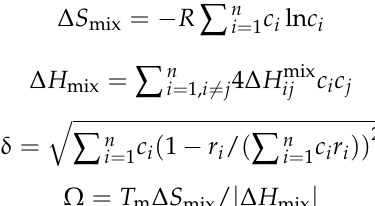
Table 1. Calculated parameters of the quasi-HEA microspheres and other reported